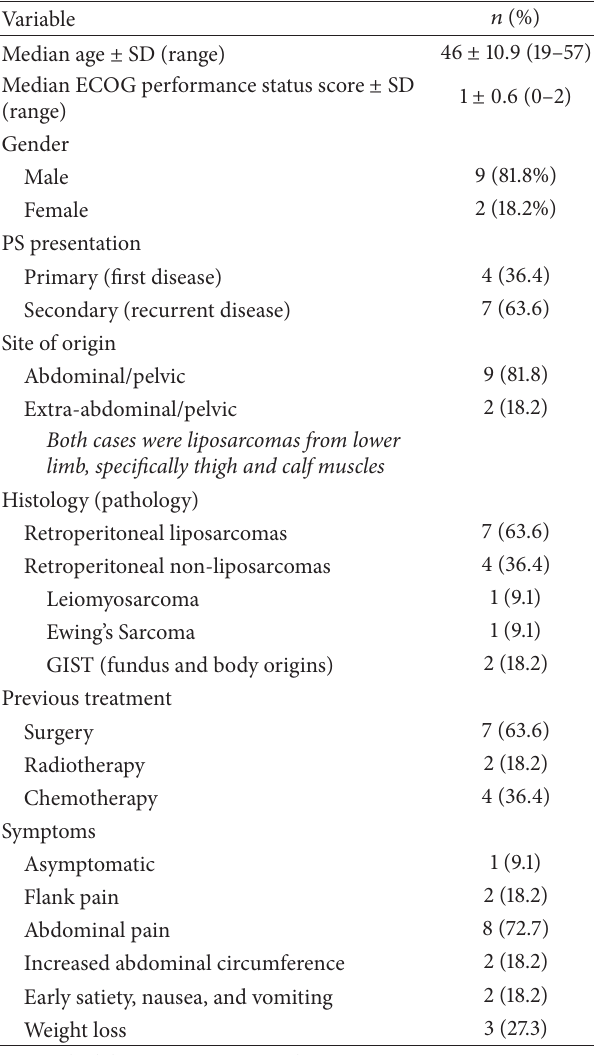
Table 1: Preoperative details of